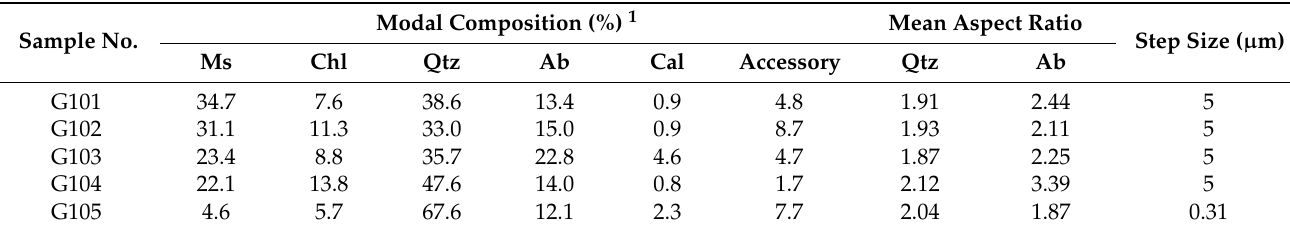
Table 1. Mineral modal composition, mean aspect ratio of grains in the phyllite samples, and step size of electron backscatter diffraction (EBSD) analysis.